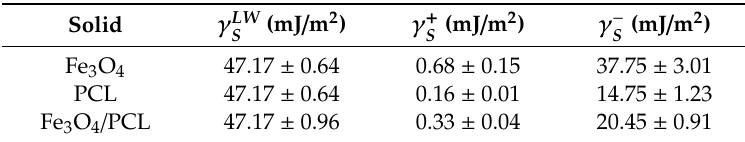
Table 2. Surface free energy components ( γ S , mJ / m 2 ) of the Fe 3 O 4 , PCL, and Fe 3 O 4 / PCL (of 2:4 Fe 3 O 4 :PCL weight ratio) particles. γ LW and electron-donor components, respectively.